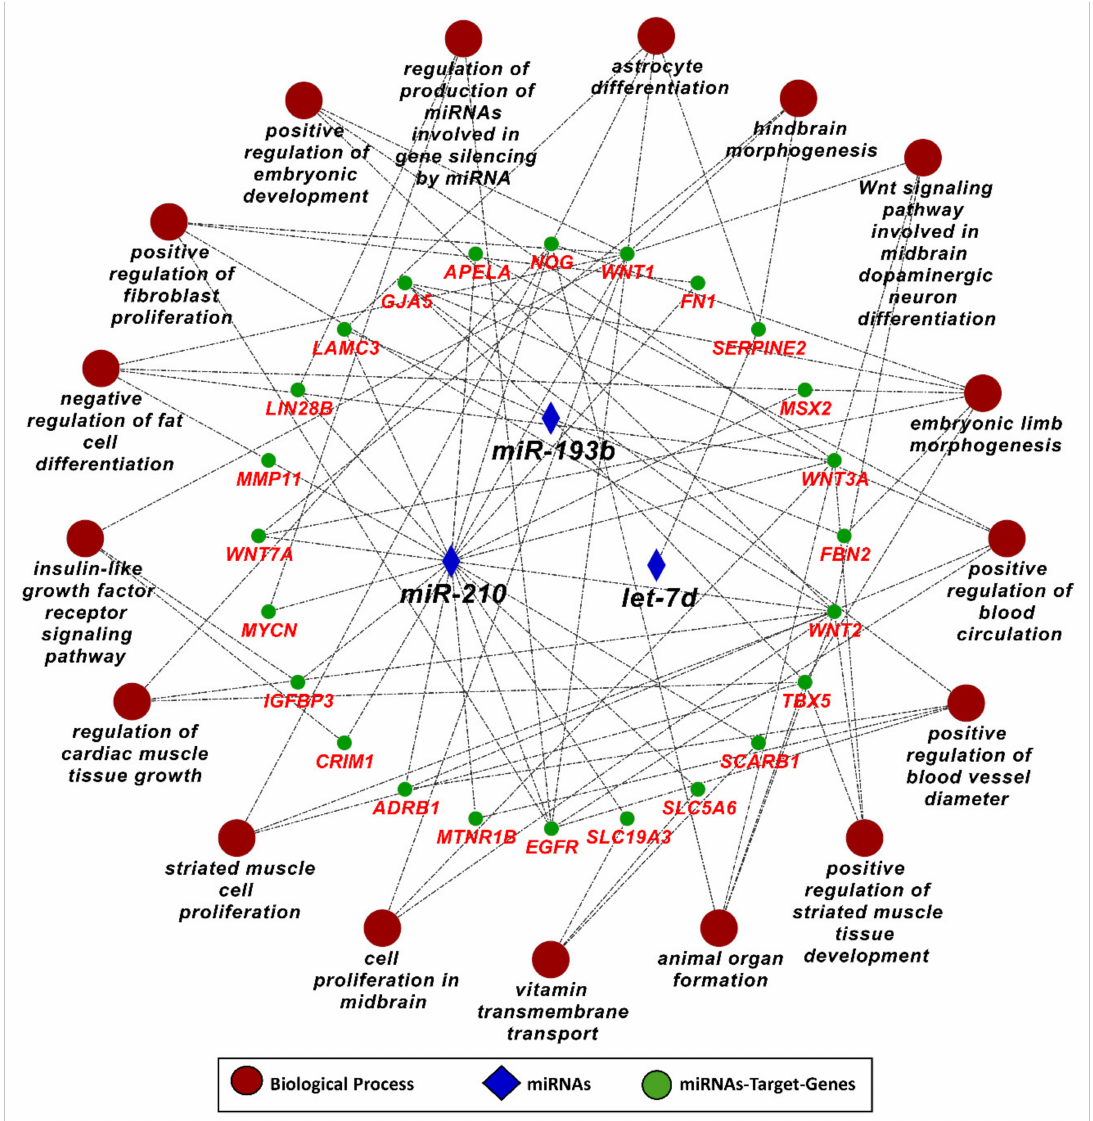
Figure 7. Gene ontology enrichment analysis for biological processes of target genes of IUGR-linked miRNAs from genes List 2, derived using ClueGO (version 2.5.1) and Cluepedia (version 1.5.7) plugin in Cytoscape (version 3.8.2) environment. A complete list of biological processes regulated by IUGR-linked miRNAs is provided in Table